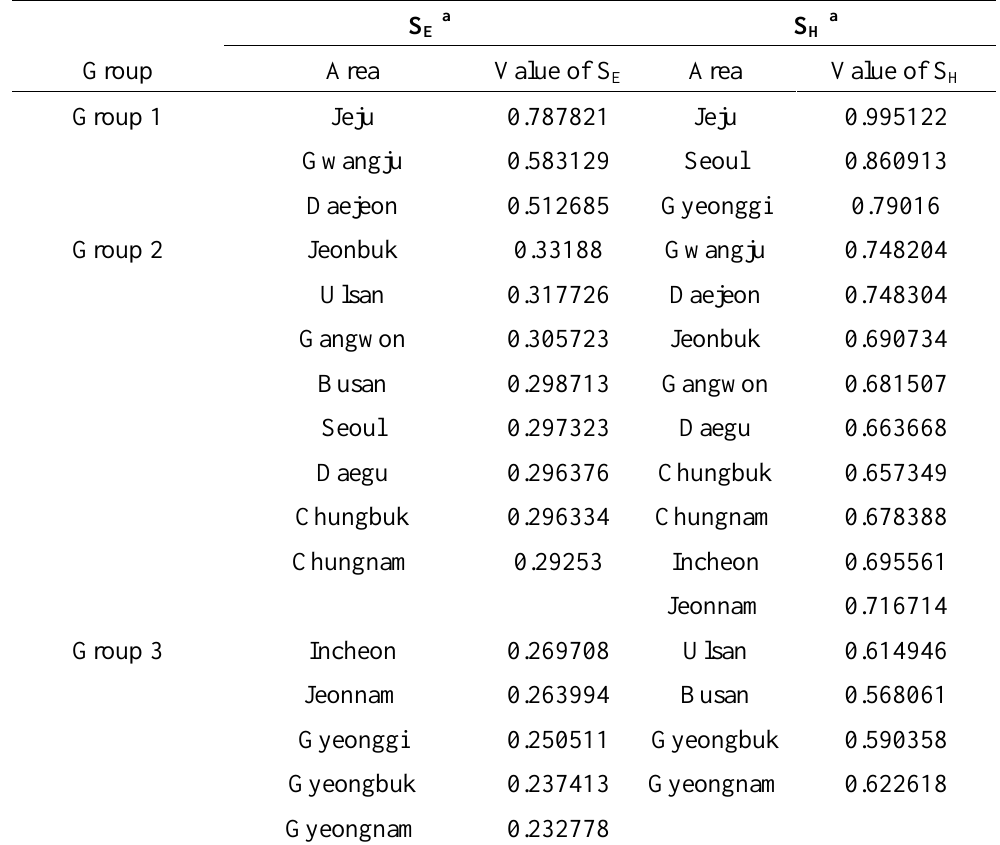
and S and the result of classification into three E H